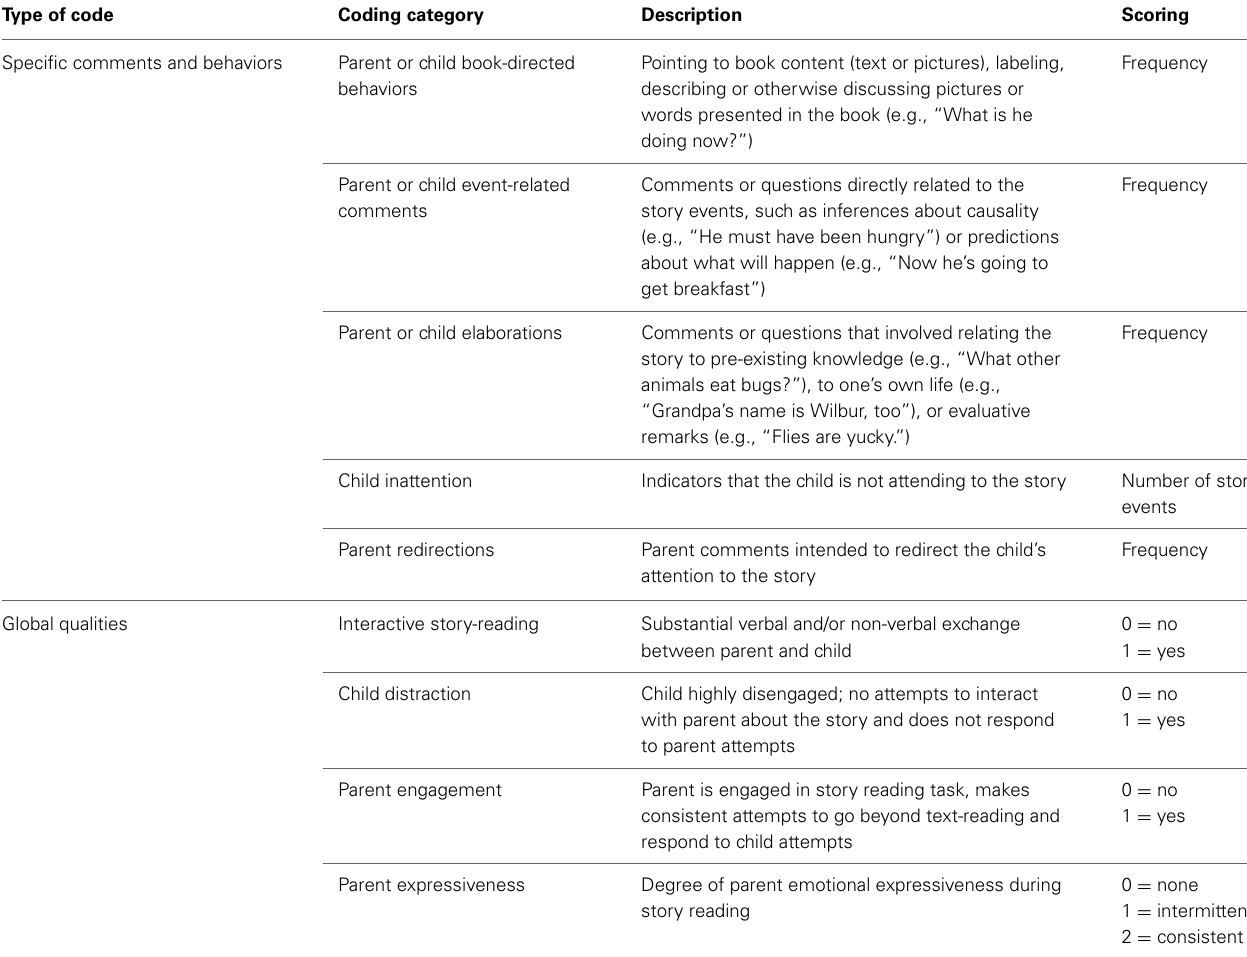
Table 1 | Story-reading interaction